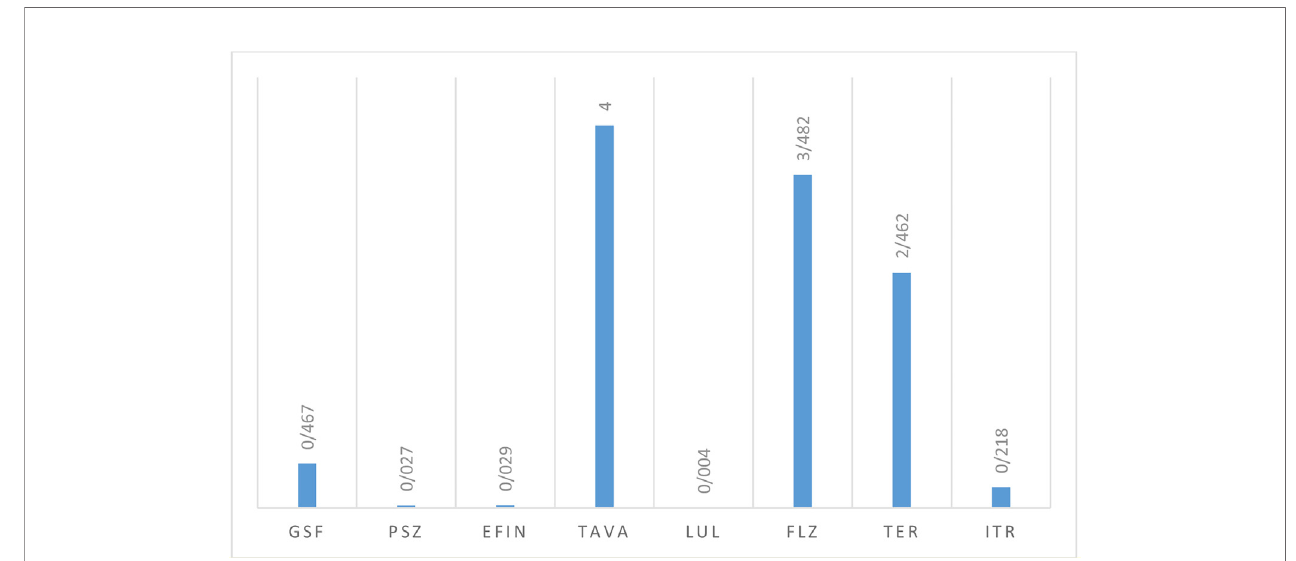
FIGURE 3 | The geometric mean obtained by testing the susceptibility of dermatophytic isolates to each antifungal agent.